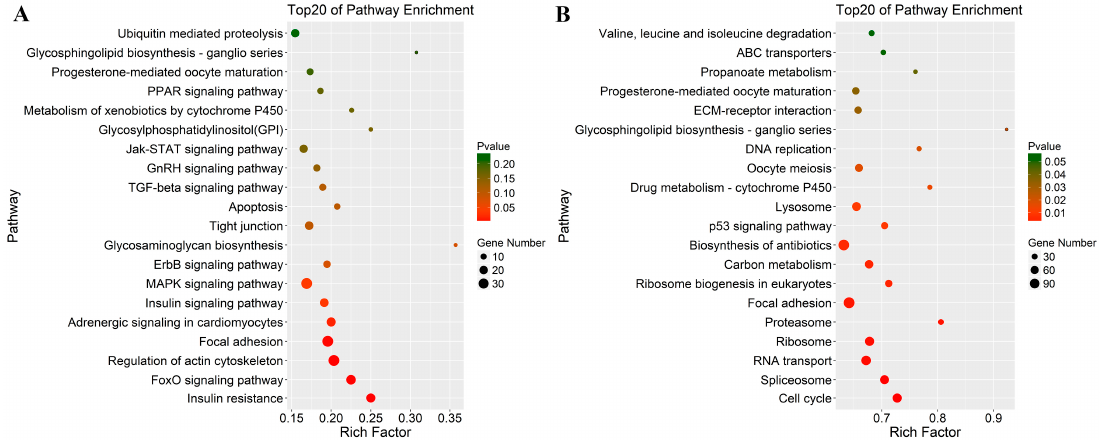
Figure 3. Kyoto Encyclopedia of Gene and Genomes (KEGG) enrichment of lncRNA-targets genes using DAVID software. ( A ) KEGG annotation for neighbor gene function of predicted lncRNAs; and ( B ) statistical KEGG enrichment for co-expressed gene function of identified lncRNAs.